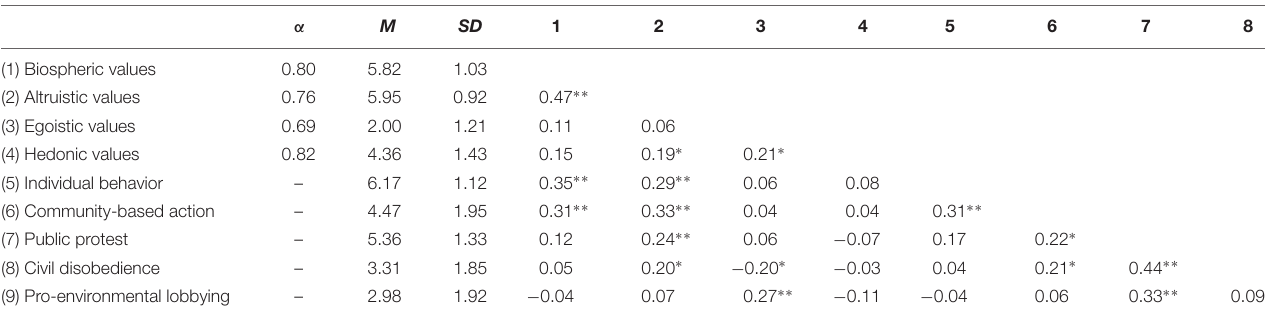
TABLE 1 | Descriptive statistics (M, SD) and bivariate correlations between